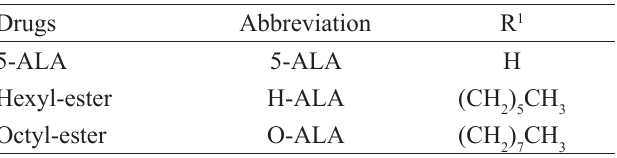
TABLE I - 5-ALA and alkyl esters: general structure